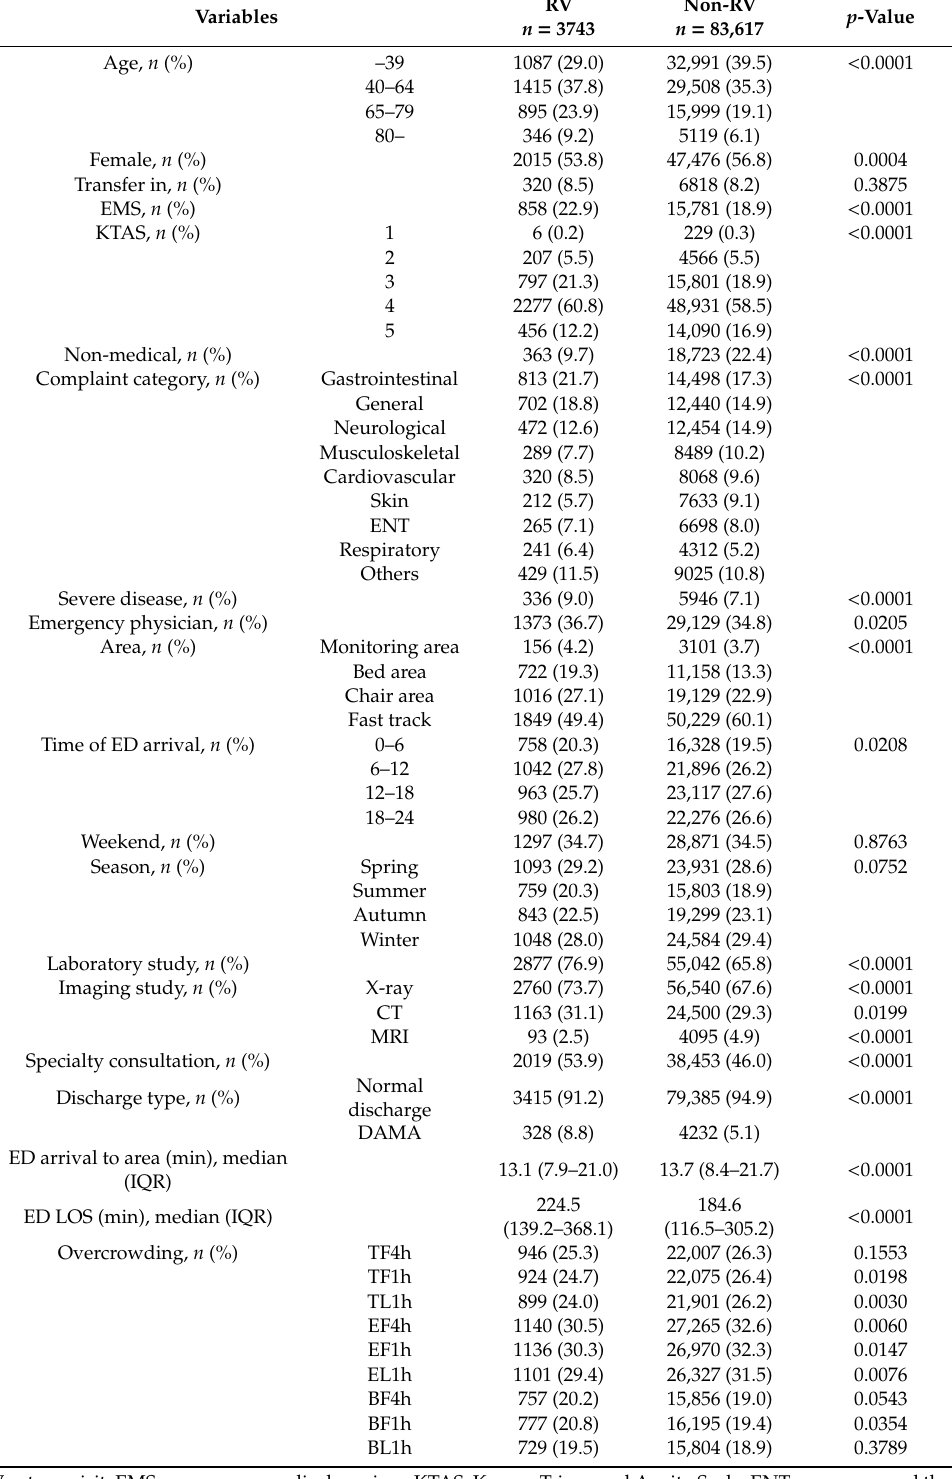
Table 1. Comparison of patient characteristics of index visits according to the occurrence of return visit within 72